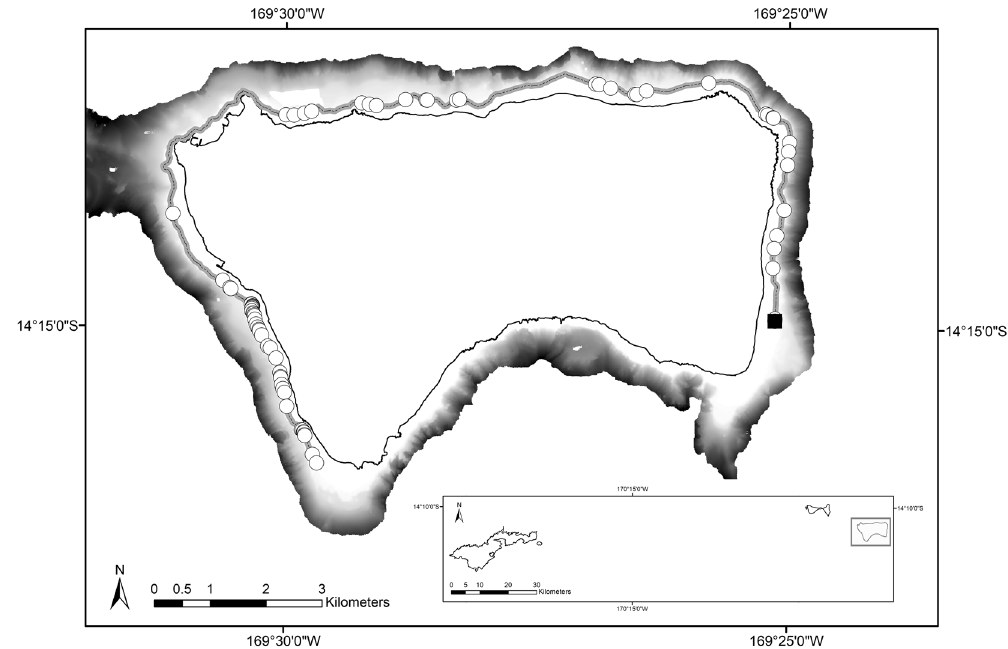
Figure 2. Tow-board survey route (indicated by the black line) around Ta’u, American Samoa and location of colonies of massive Porites observed within scale 3 (> 10 m diameter; represented by white circles). The black box designates the location of Ta’u within the Territory and the black square indicates the location of the largest colony